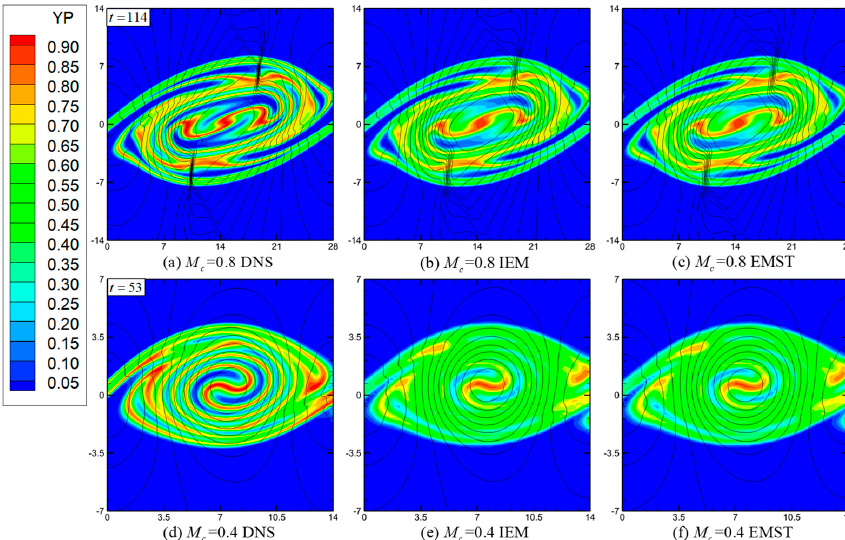
Figure 5. Instantaneous results of mass fraction of product showing the evolution of the compressible mixing layer: contour plots for M c = 0.8 case calculated by ( a ) DNS, ( b ) FMDF-IEM, ( c ) FMDF-EMST and plots for M c = 0.4 case calculated by ( d ) DNS, ( e ) FMDF-IEM, ( f ) FMDF-EMST.